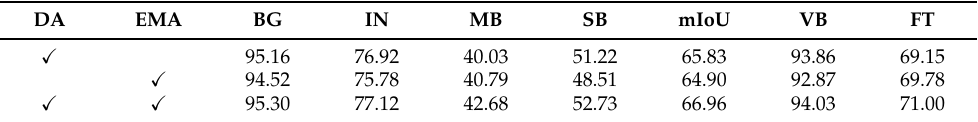
Table 7. Detailed configuration of DA-EMA units.